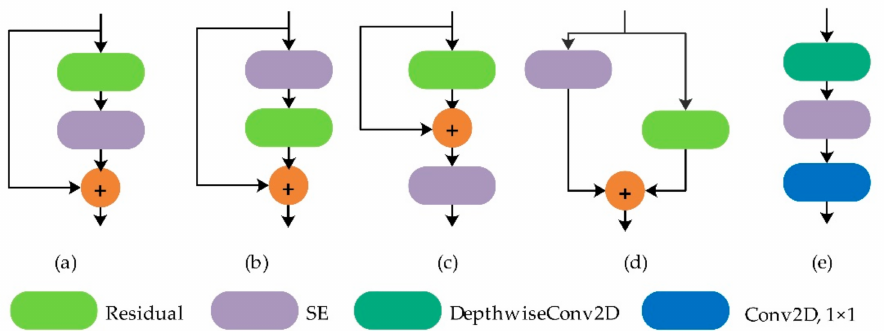
Figure 3. SE-DEEP block: SE model deeply fused to depth-wise separable convolution block: ( a ) Standard SE block; ( b ) SE-PRE block; ( c ) SE-POST block; ( d ) SE-Identity block; ( e ) SE-DEEP block(proposed